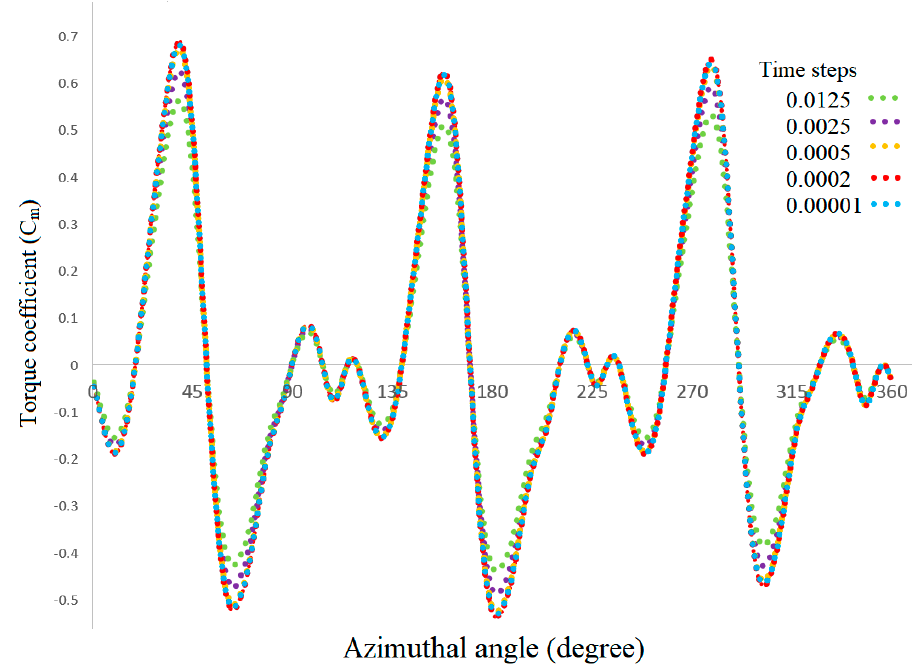
Figure 5. Torque coefficient ( C m ) vs. azimuthal angle for five different time steps.